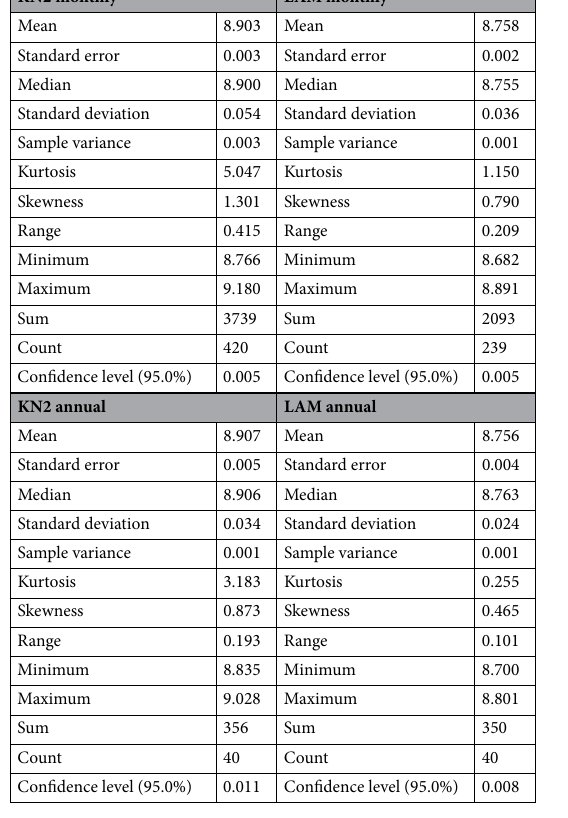
Table 3. Descriptive statistic of raw data of coral Sr/Ca from MCA (LAM) and Enggano (KN2)